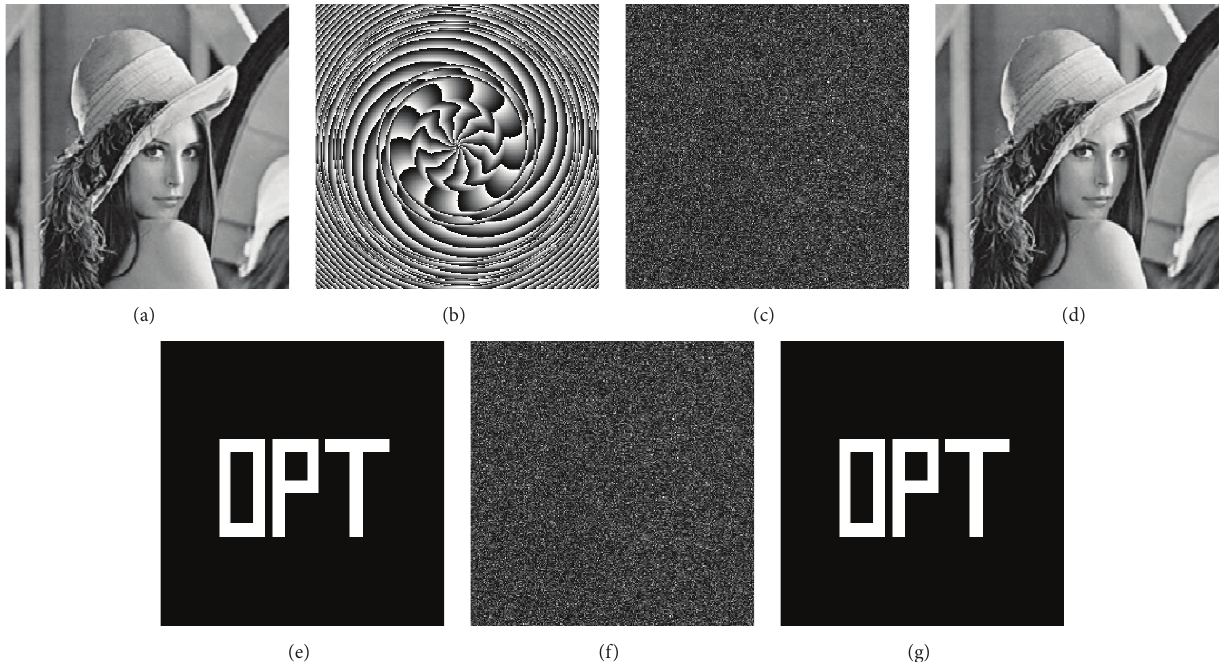
Figure 3: Results of validation of the proposed scheme for grayscale and binary images: (a) input image Lena of size 256 × 256 pixels; (b) DVTL 𝑆=3 phase key at pixel spacing = 0.023, 𝜆 = 632.8 nm, 𝑓 = 350 mm, 𝑚 = 11 , and 𝑆 = 3 ; (c) encrypted image; (d) decrypted image;